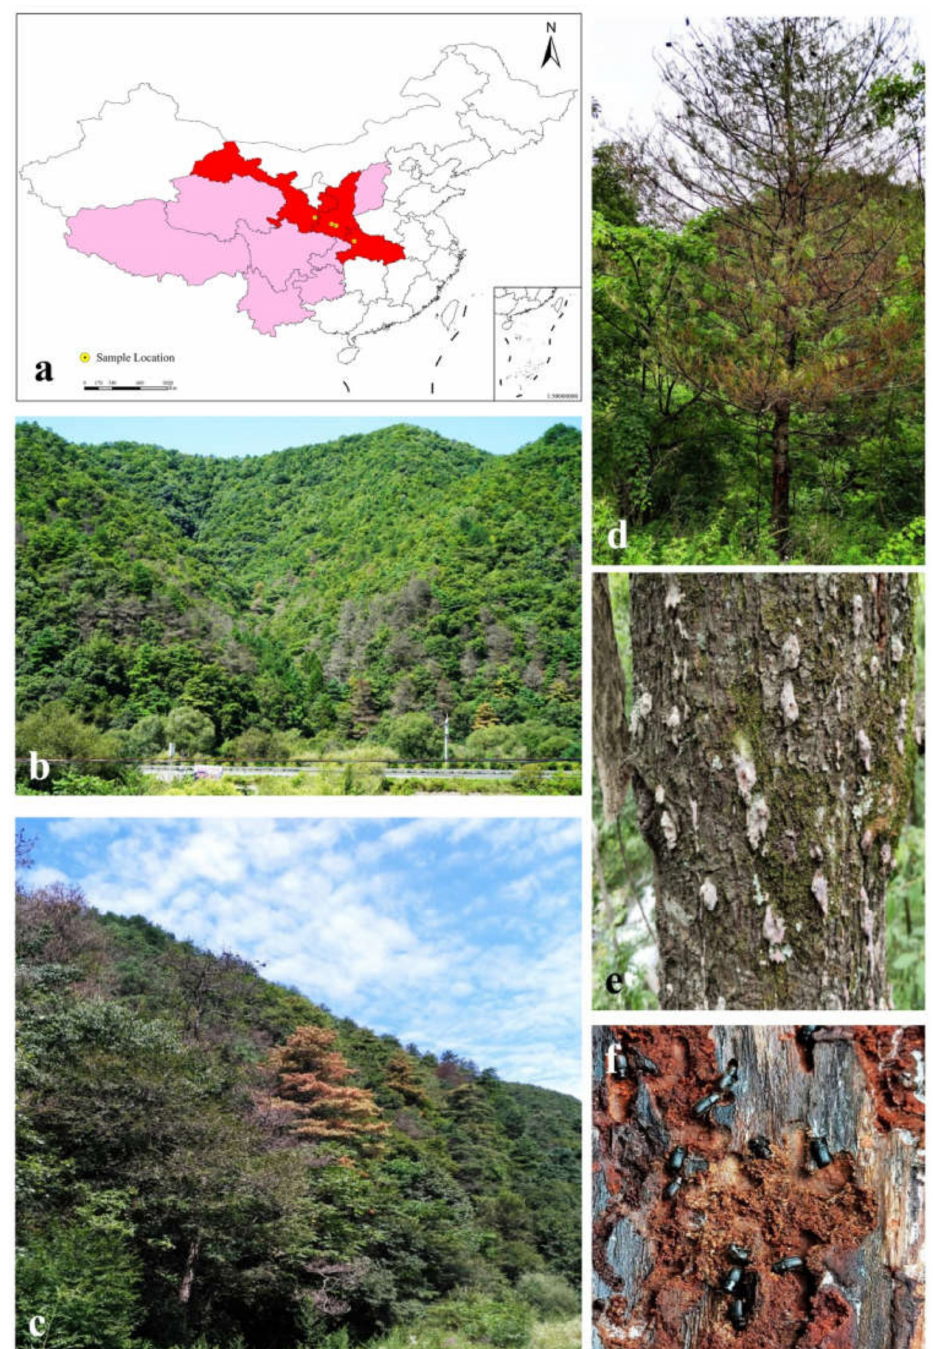
Figure 1. ( a ) Map showing the distribution of P. armandii and sample locations of D. armandi in China. ( b – e ) Disease symptoms of P. armandii infested by D. armandi and ophiostomatoid fungi in the Qinling Mountains of western China. ( f ) Adult D. armandi in galleries on P. armandii